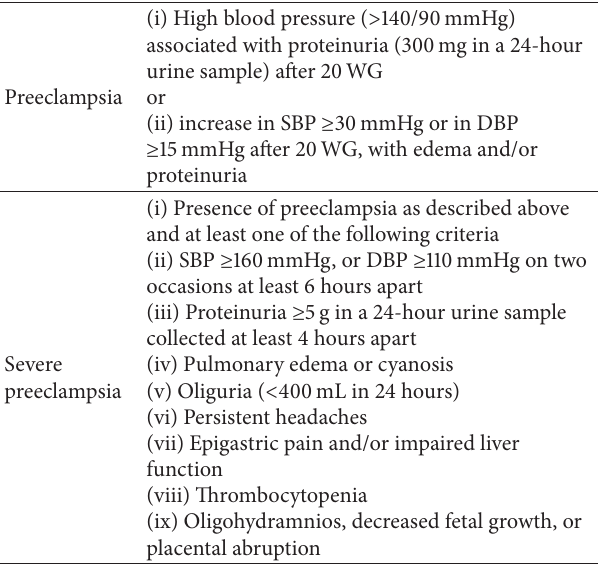
Table 2: Preeclampsia